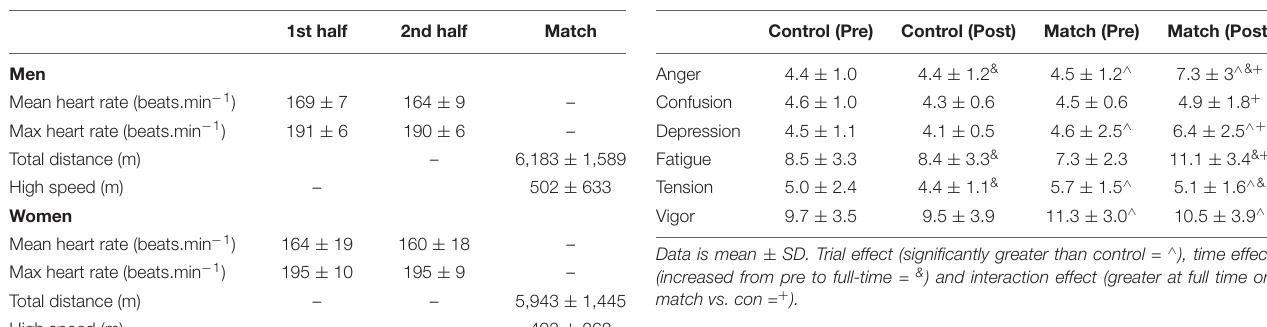
TABLE 3 | Mood data for all